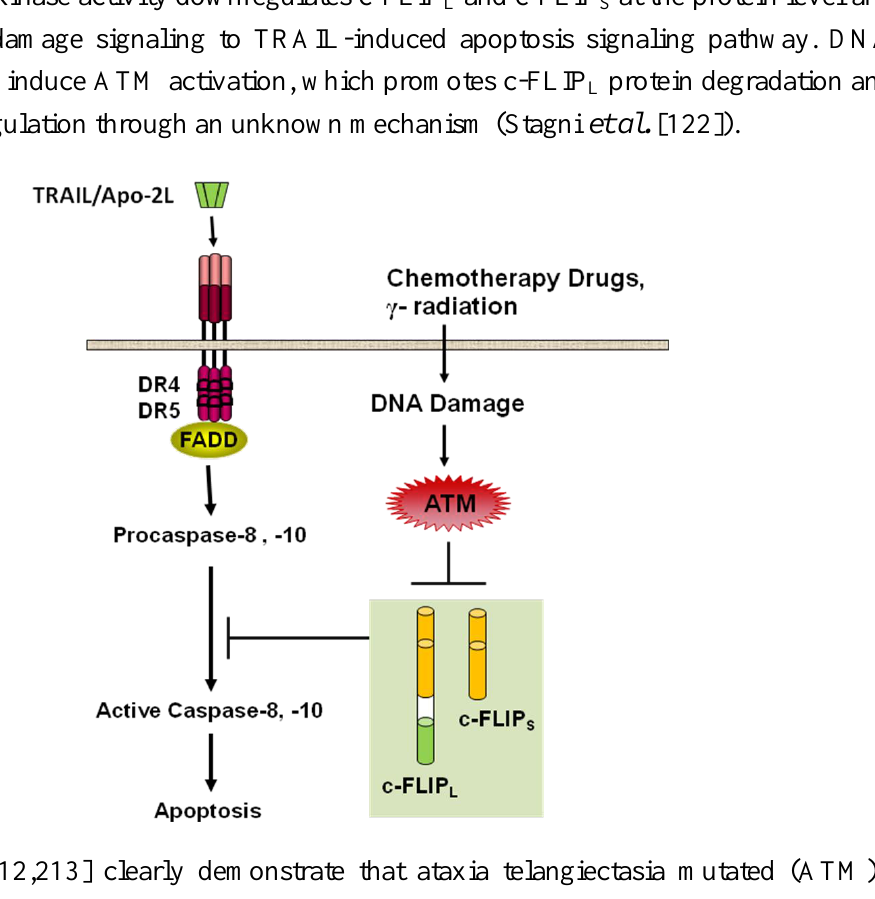
and c-FLIP at the protein level and L S protein degradation and L